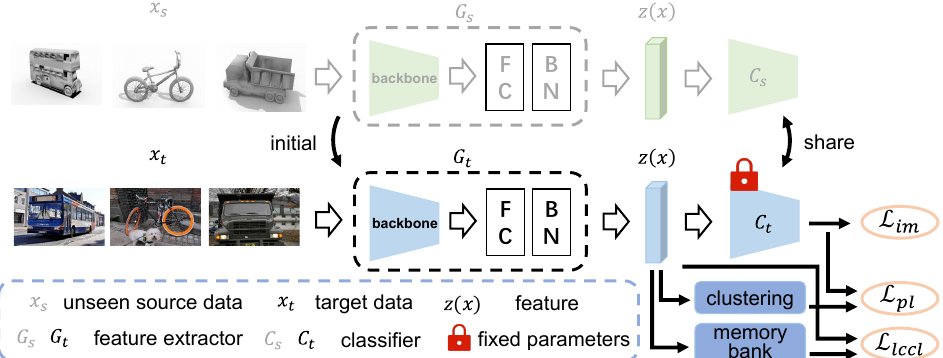
Figure 2. The pipeline of our LCCL framework. The source model consists of the feature learning module and the classifier module. LCCL fix the weight parameters of classifier and utilizes the feature learning module as initialization for target domain learning. The method includes three losses, information maximization loss L im , pseudo labeling loss L pl and label consistency contrastive learning loss L lccl